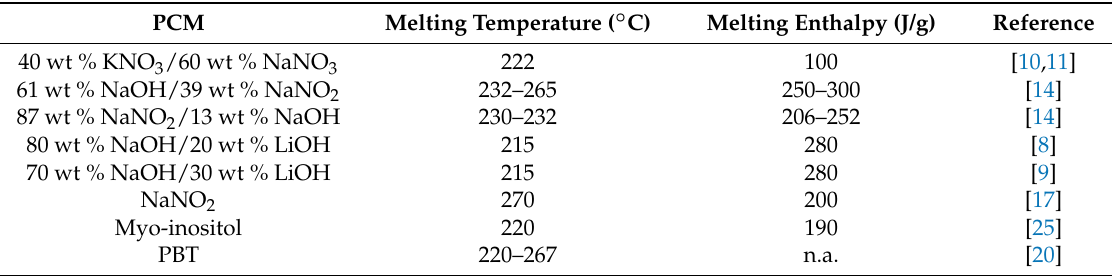
Table 4. Literature thermophysical characterization of PCMs.